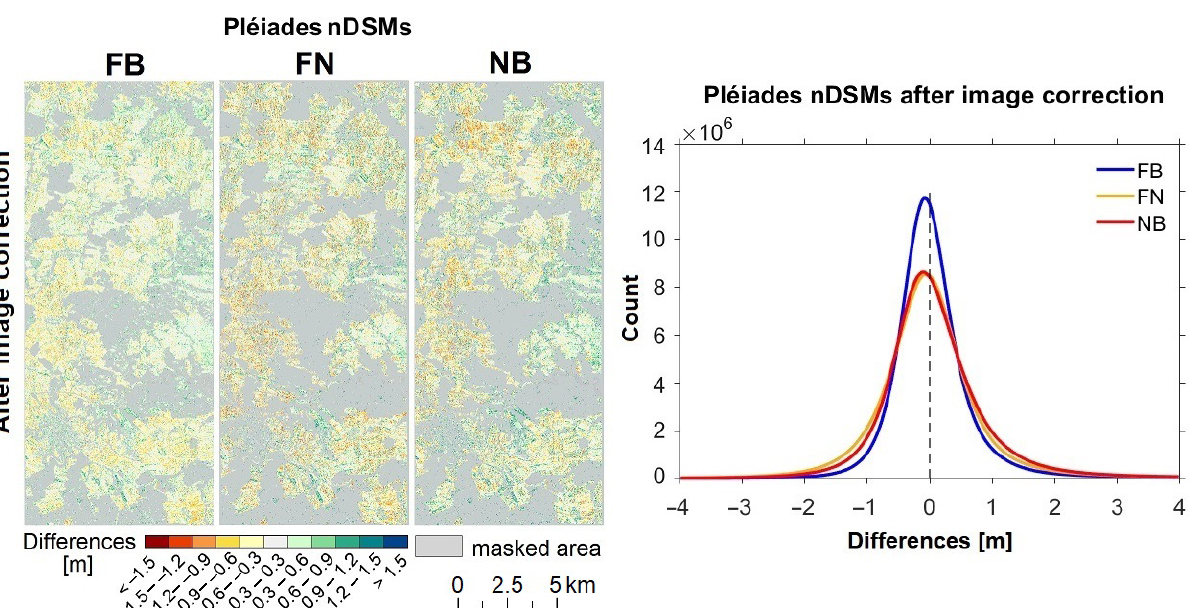
Figure 17. Pléiades nDSMs for open areas after image correction (RPC refinement with 300 GCPs). Color-coded height differences (masked areas are shown in grey) with corresponding frequency distribution of height discrepancies of Pléiades DSMs against reference Lidar DTM (to be compared with Pléiades nDSMs before image correction in Figure